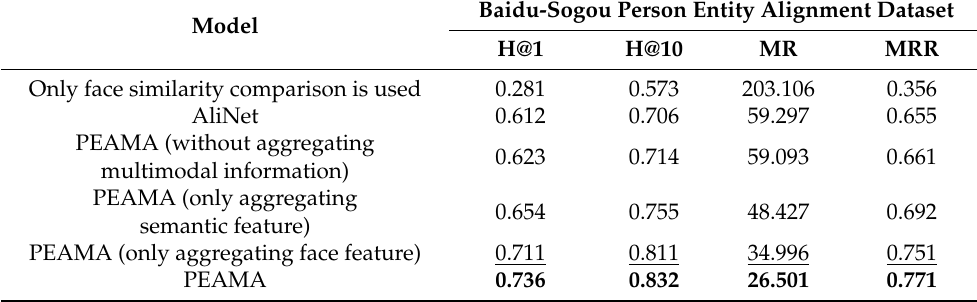
Table 3. Comparison of the effects of PEAMA and AliNet.The best results are marked in bold and the second-best results are